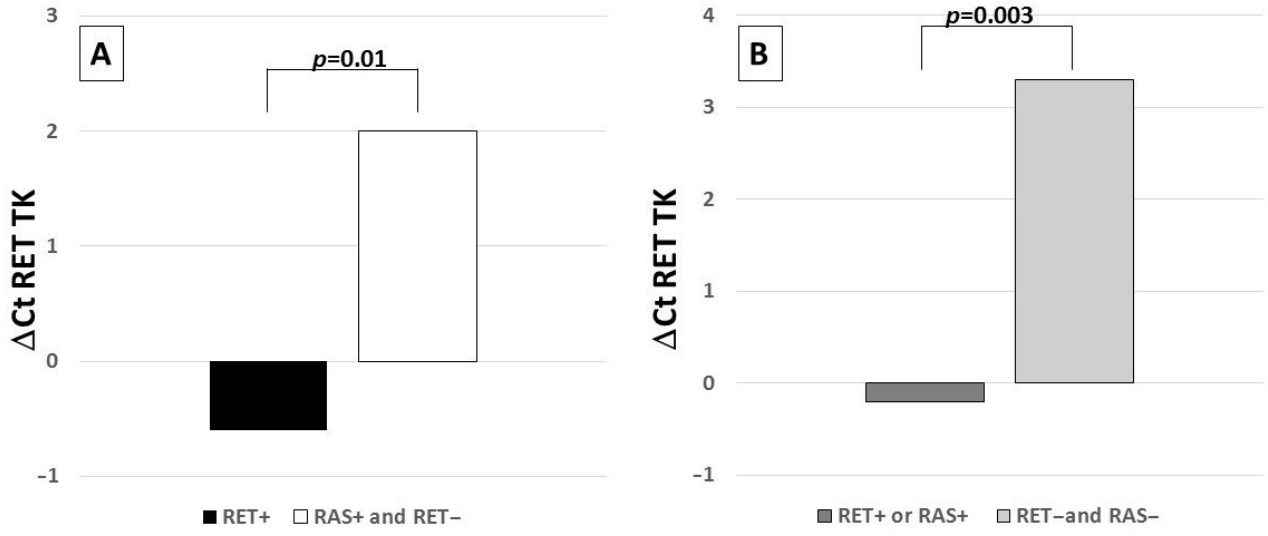
Figure 2. ( A ): RET gene expression levels according to the somatic mutation profile. A statistically significant higher RET gene expression level was observed in RET + cases with respect to RET − and RAS + cases. ( B ): gene expression levels according to the somatic mutation profile. A statistically significant higher RET gene expression level was observed in RET + or RAS + cases with respect to cases negative for both gene alterations ( RET − and RAS − ).